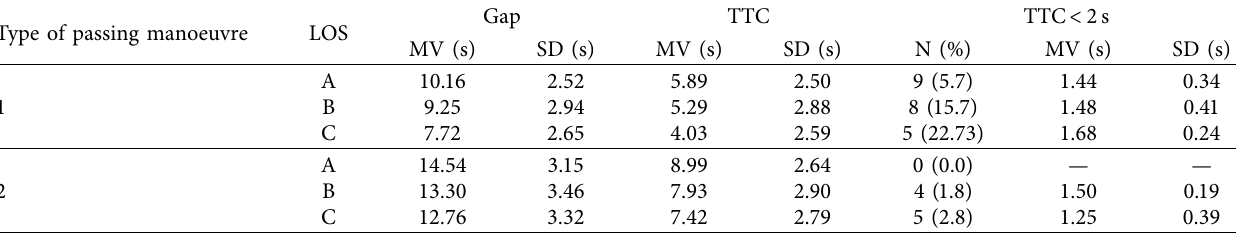
Table 11: Mean value and standard deviation of the gap, TTC, and risky